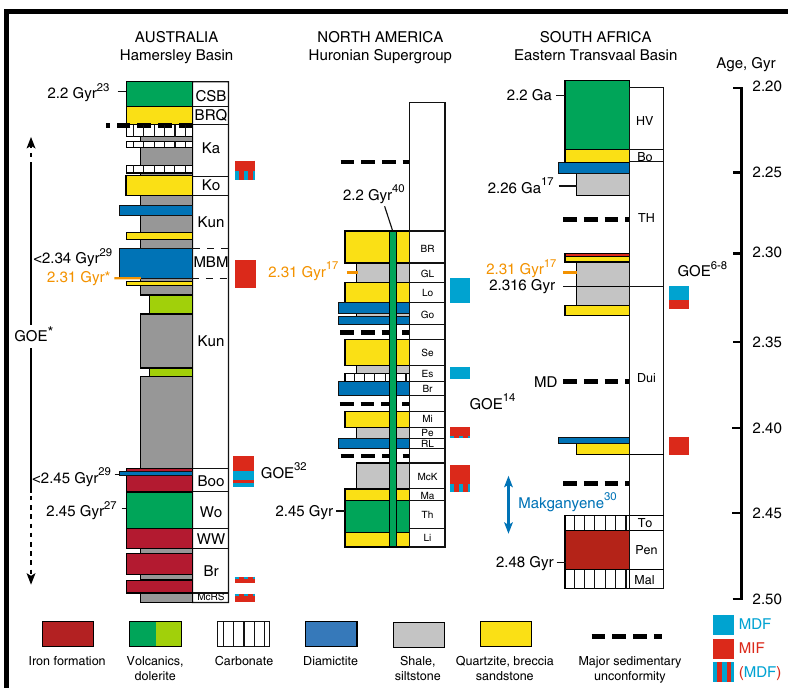
Fig. 1 New age-calibrated correlation of Late Archaean to Paleoproterozoic sedimentary successions. The Re-Os sulphide age from this study is shown as 2.31 Ga*. Other age constraints are labelled accordingly. Ages with no reference can be found in Rasmussen et al. 17 . The inferred Great Oxidation Event (GOE*) from this study is shown as a ~300 Myr interval based on combined age, sulphur isotope and stratigraphic data. Other GOEs inferred from previous studies are labelled accordingly. The vertical arrow labelled Makganyene 30 refers to the range of age inferred for the Makganyene glacial deposit based on a new U-Pb age of the Ongeluk Volcanics, Transvaal Supergroup, South Africa 30 . MIF, mass-independent fractionation of sulphur isotopes; MDF, mass- dependent fractionation of sulphur isotopes. The mixed light blue-red domain labelled (MDF) shown at the top of the Turee Creek Group (this study), in the Whaleback Member of the Brockman Formation 39 and McRae Shale Formation 10 of the Hamersley Group, and at the base of the Huronian sedimentary column 14 – 16 , corresponds to sedimentary horizons in which strongly attenuated Δ 33 S and Δ 33 S/ Δ 36 S systematics are attributed to increases in p O 2 above 10 – 5 to 10 − 2 PAL (see text). Hamersley Basin: McRS, McRae Shale Formation, Br, Brockman Formation, WW, Weeli Wolli Formation, Wo,